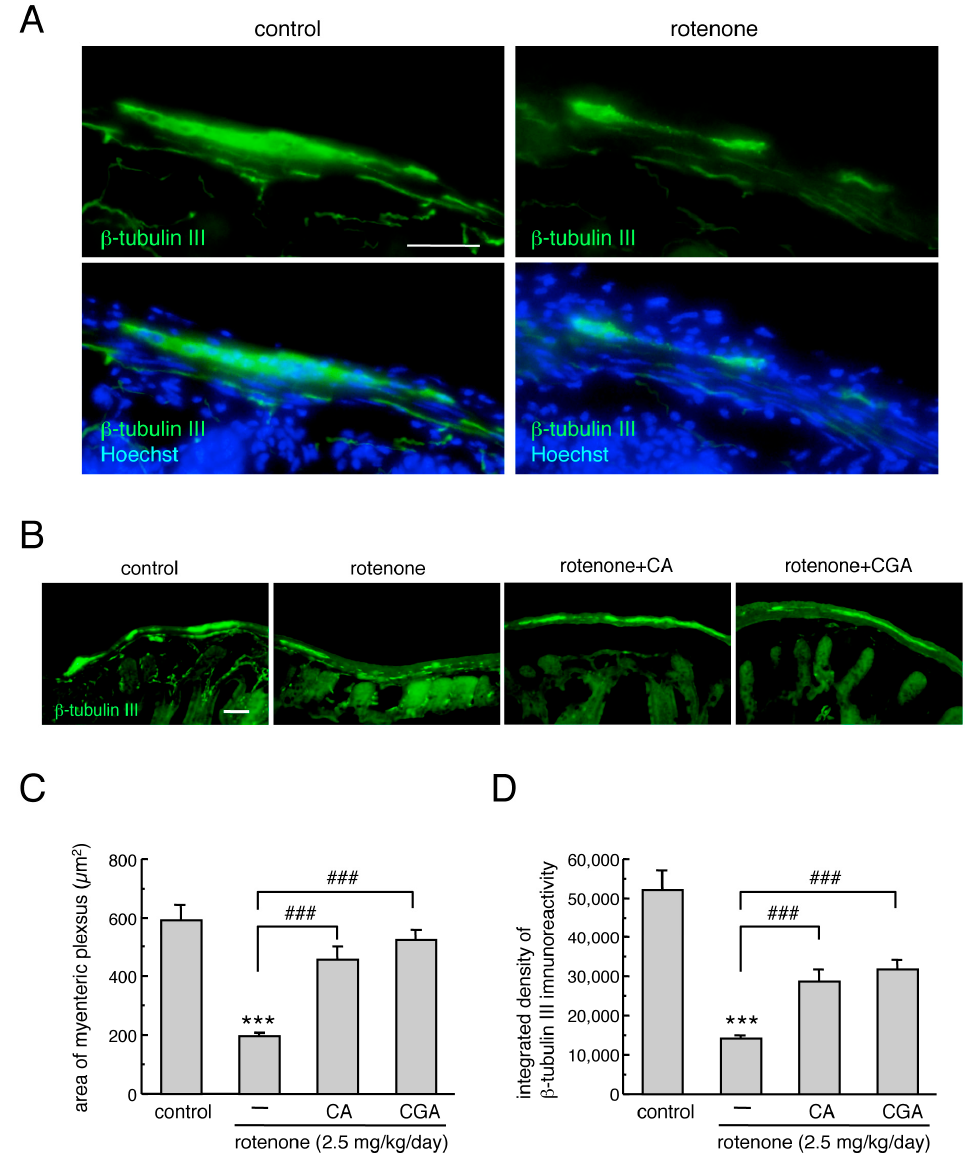
Figure 3. Administrations of CA or CGA prevented the degeneration of enteric neurons in the intestinal myenteric plexus of rotenone-treated mice. ( A ) Representative photomicrographs of immunohistochemistry for β -tubulin III in the intestine of mice. Green: β -tubulin III-positive neurons. Blue: nuclear staining with Hoechst 33342. Scale bar = 50 µ m. ( B ) Representative photomicrographs of β -tubulin III-positive neurons in the intestine of rotenone-treated mice after treatment with CA (30 mg/kg/day) or CGA (50 mg/kg/day). Scale bar = 50 µ m. ( C , D ) Quantitation of β -tubulin III-positive signals in the intestine. ( C ) Area of β -tubulin III-positive myenteric plexus, ( D ) integrated density of β -tubulin III immunoreactivity. Data are means ± SEM (n = 6–7). *** p < 0.001 vs. the vehicle-treated control group, ### p < 0.001 between the two indicated groups.